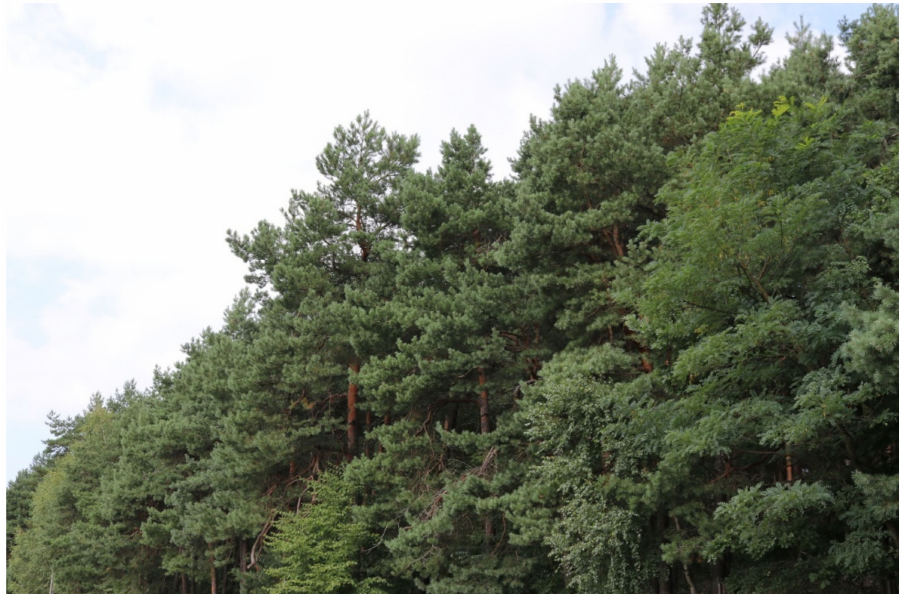
Figure 9. A photograph of stand A1 taken in 2021, 13 years after the liquidation of the timber